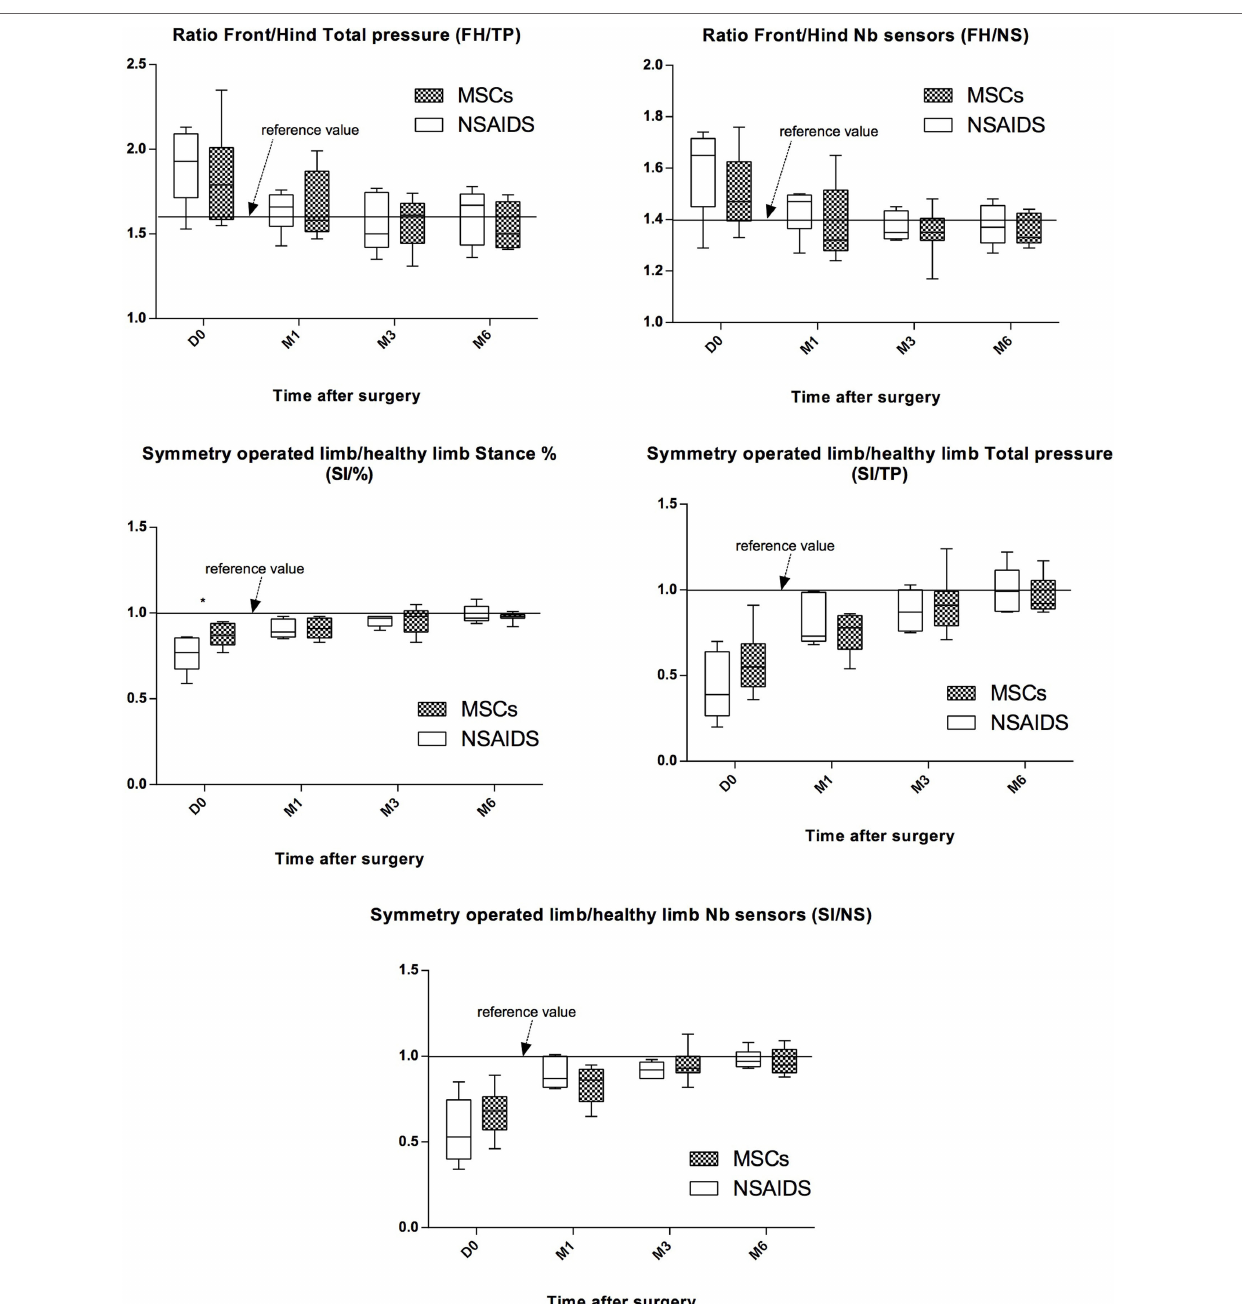
FiGUrE 3 | Evolution of pressure walkway values between preoperative (D0) and postoperative (M1, M3, and M6) evaluations for both groups for the five studied parameters. Black line represents reference values observed in healthy animals. All values represent the means ± SD. Improvement was observed in both groups for the five studied parameters. No significant difference was observed between the non-steroidal anti-inflammatory drugs (NSAIDs) and mesenchymal stromal cells (MSCs) groups for any parameter after